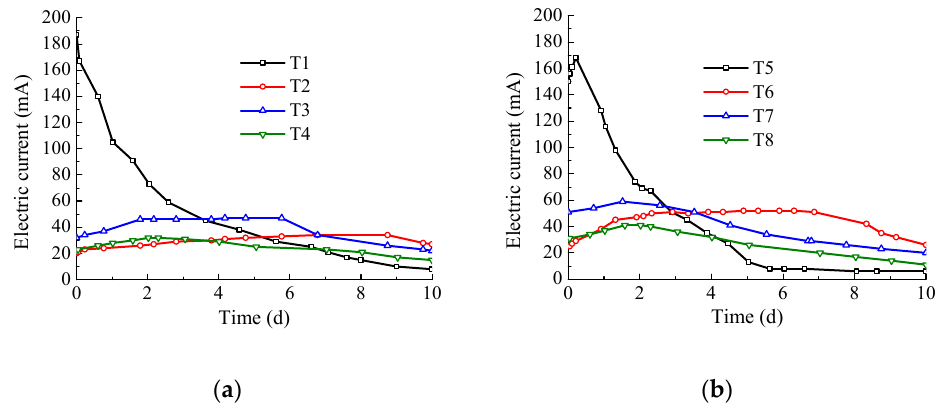
Figure 2. Electric current changes over 10 days. ( a ) EK Remediation; ( b ) EK-PRB Remediation.